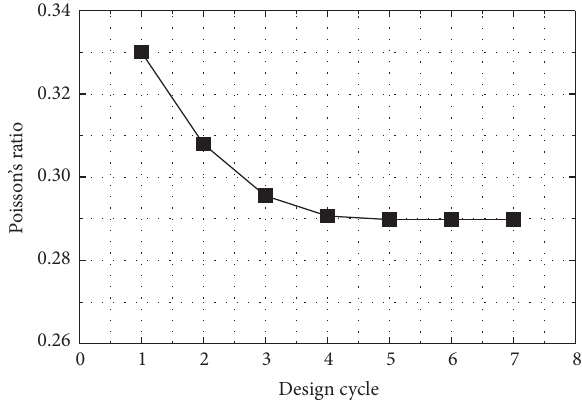
Figure 10: Variation of Poisson’s ratio with the design cycles.